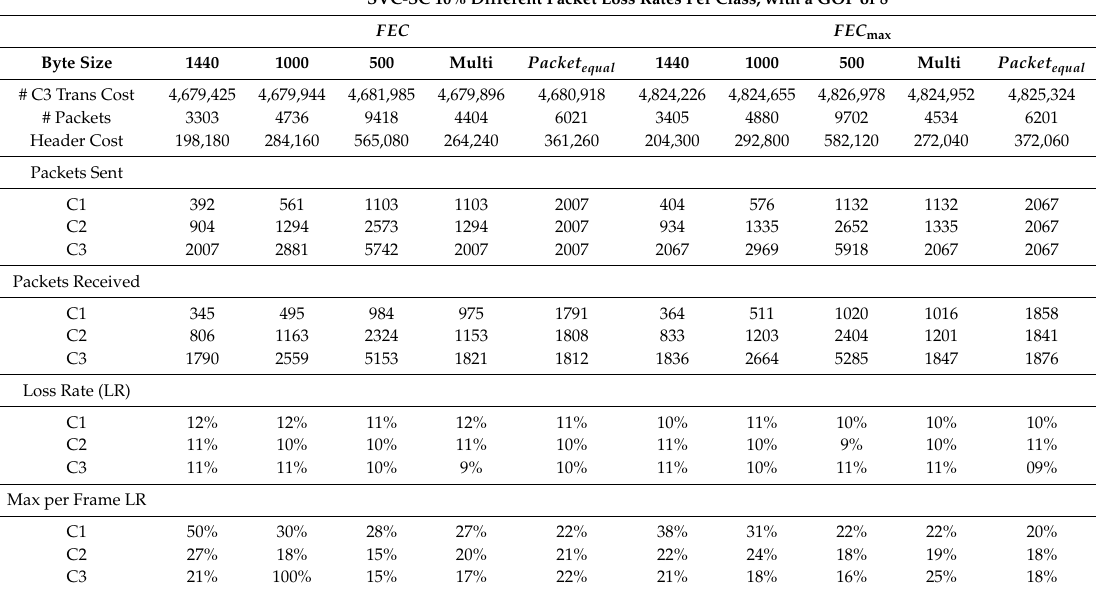
Table A6. FEC and FEC max models for all four Packet thres , as well as Packet equal . Values are illustrated for packets transmitted, additional packet header cost (60 bytes per packet) and individual packets sent, packets received, loss rate per class and maximum loss rate per frame for SVC-SC, for an overall packet loss rate of 10% and a GOP of